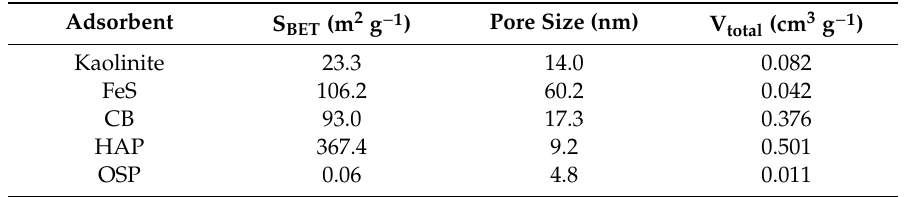
Table 1. BET surface areas, average pore sizes and total pore volumes (V total ) of five